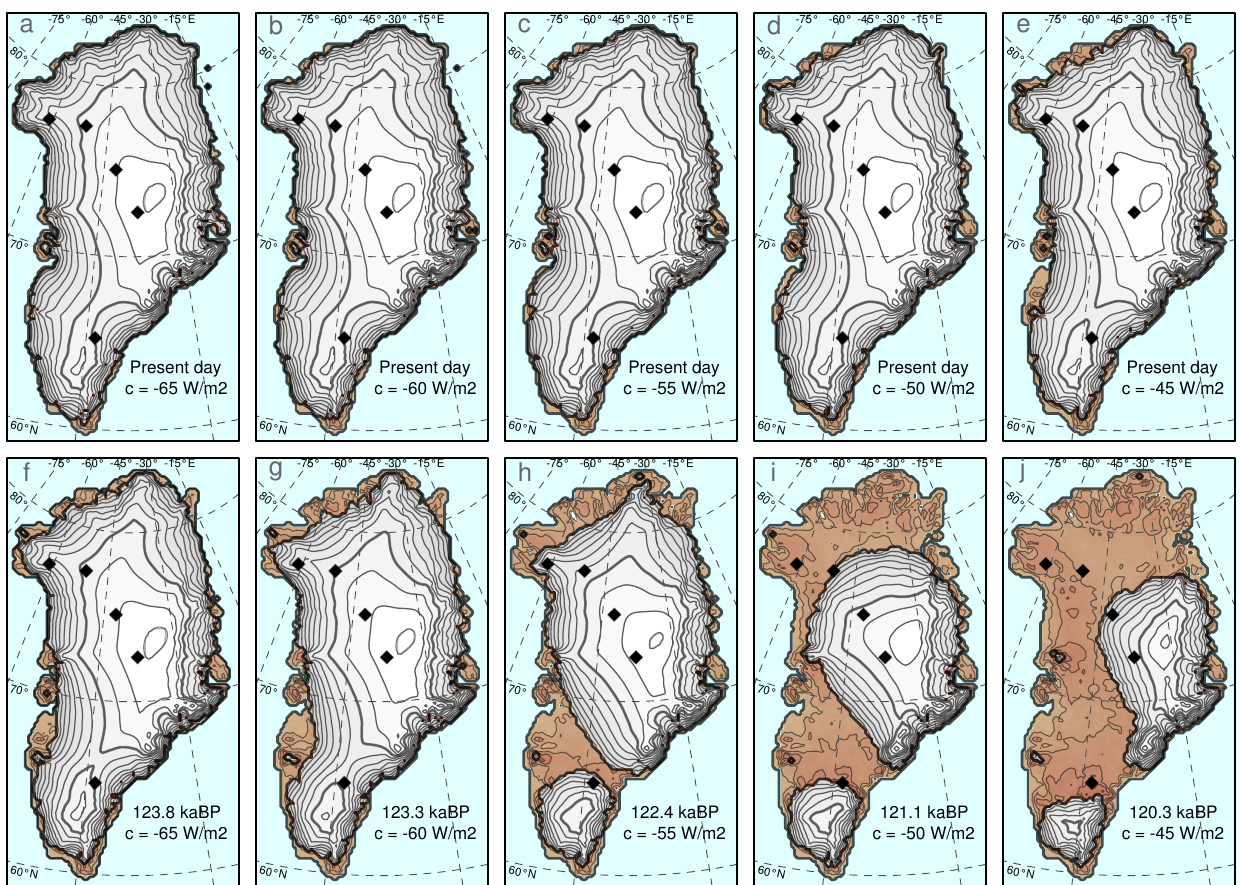
Fig. 4. GIS distribution for different values of the melt parameter c , as simulated for (a–e) the present and (f–j) the Eemian minimum volume. The black diamonds show the locations of ice core drill sites (from South to North: DYE-3, GRIP, NGRIP, NEEM and Camp